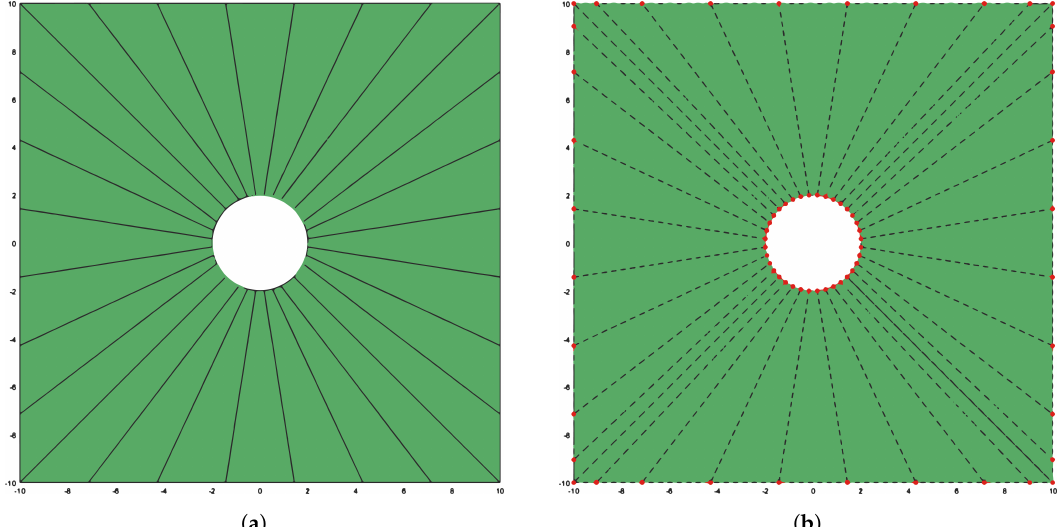
Figure 5. Case 1: physical domain, initial mesh and control points. ( a ) The physical mesh; ( b ) the control point for the NURBS surface.